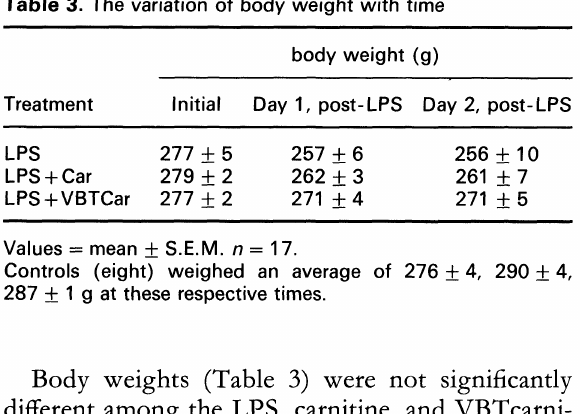
Table 6. Liver carnitine levels at 30 h